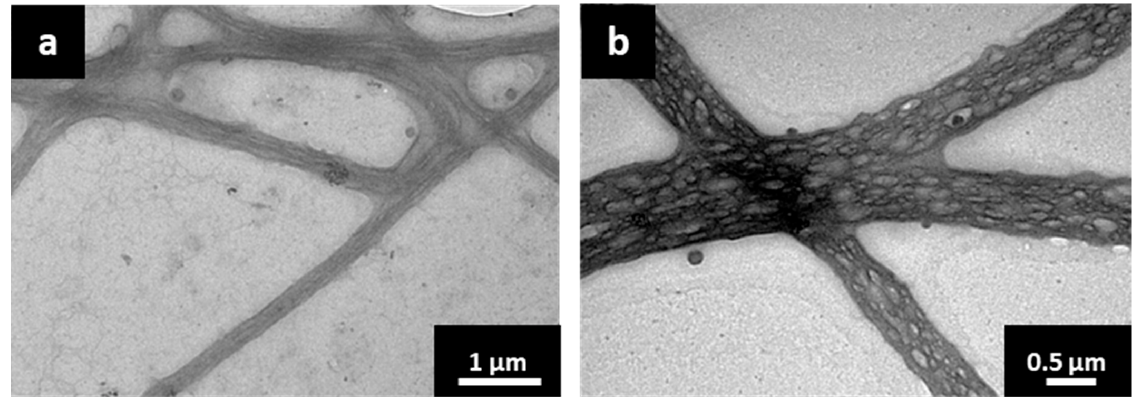
Figure 3. TEM images of ( a ) EMPTY-NF with fibrous inner structure and ( b ) SIM LIPO-NF with brighter compartmental spots, which might be due to evaporated water from the liposomes.